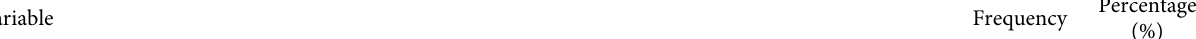
Table 6: Posttransfusion initiation nursing